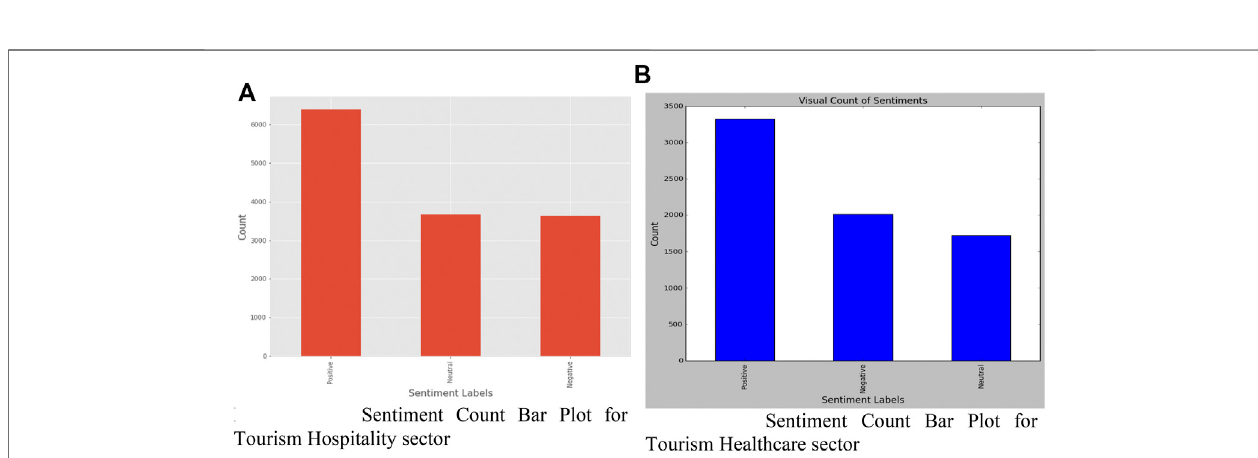
FIGURE 5 | (A) Histogram of compound scores for tourism hospitality (B) Histogram of compound scores for tourism healthcare.